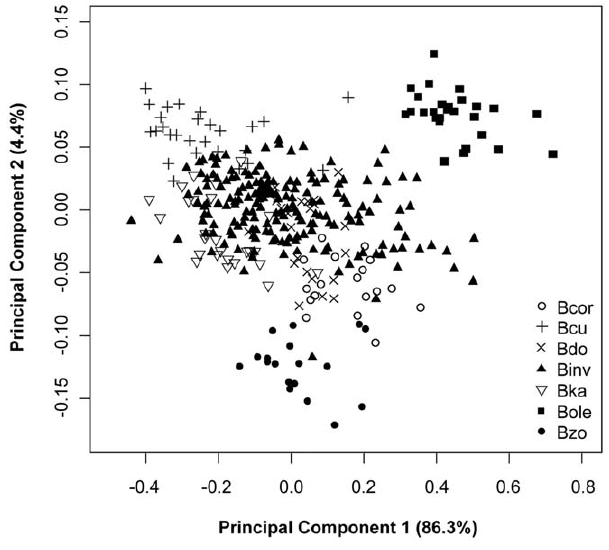
Figure 1. Projection of the wing and tibia data of Bactrocera invadens compared with the other Bactrocera species on the first two principal components.